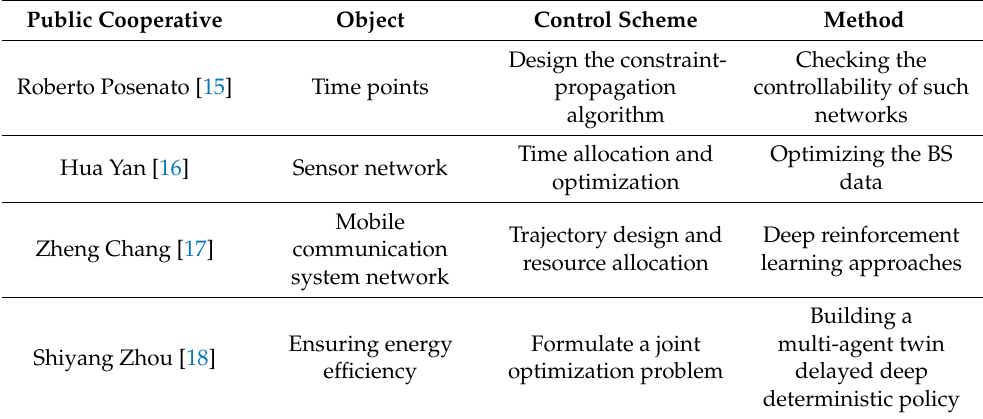
Table 1. Domain partitioning of architecture design for architecture